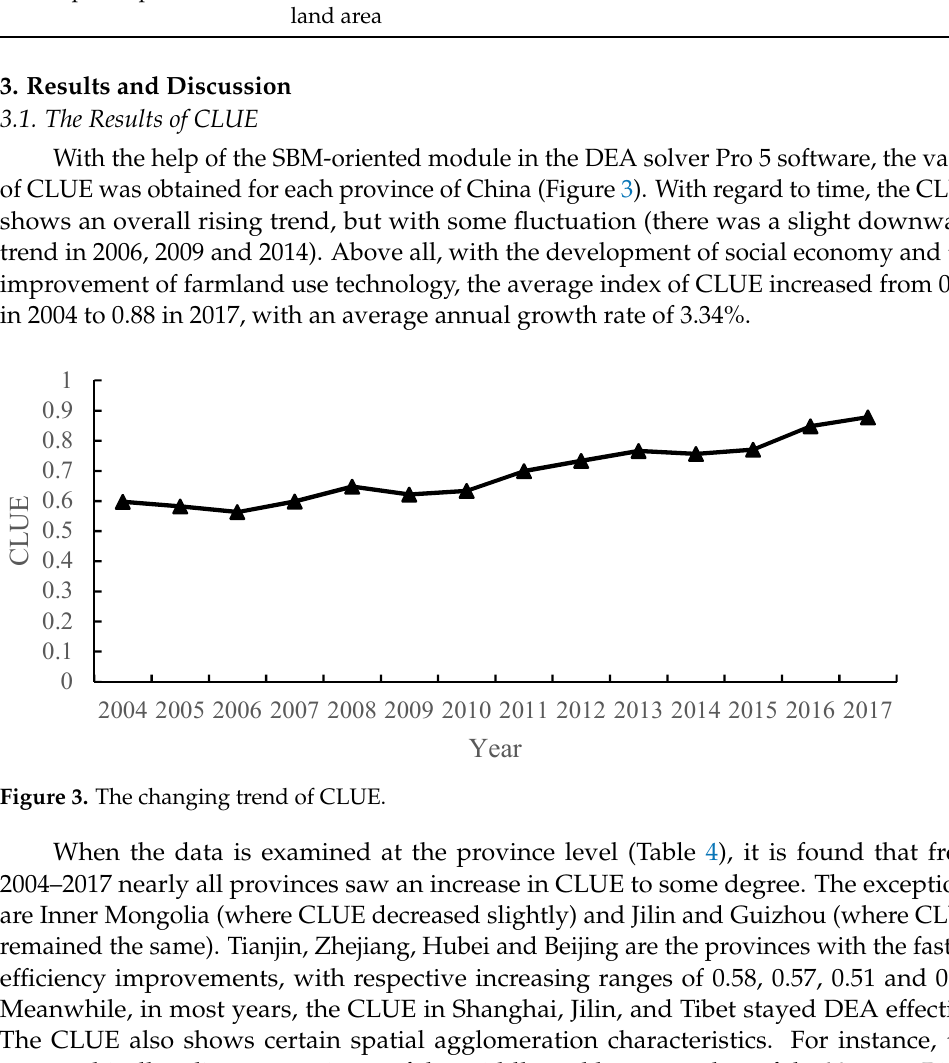
Table 4. The results of CLUE in major years.